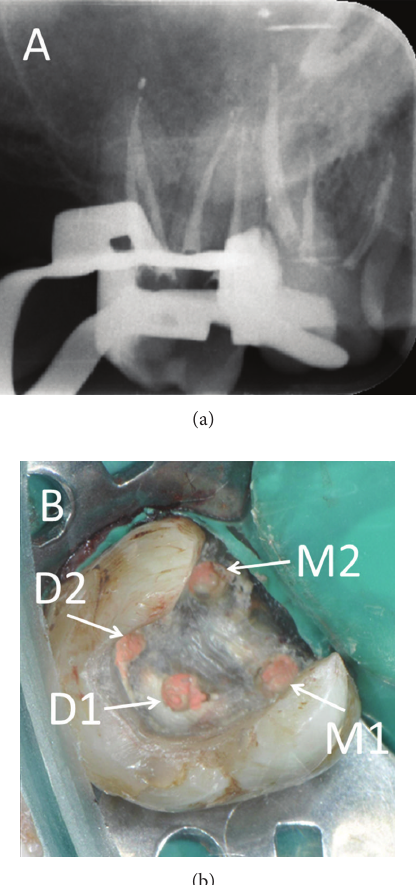
Figure 2: (a) Postoperative periapical radiograph taken immedi- ately after completion of the root canal treatment. (b) The location of four root canal orifices after root canal filling.